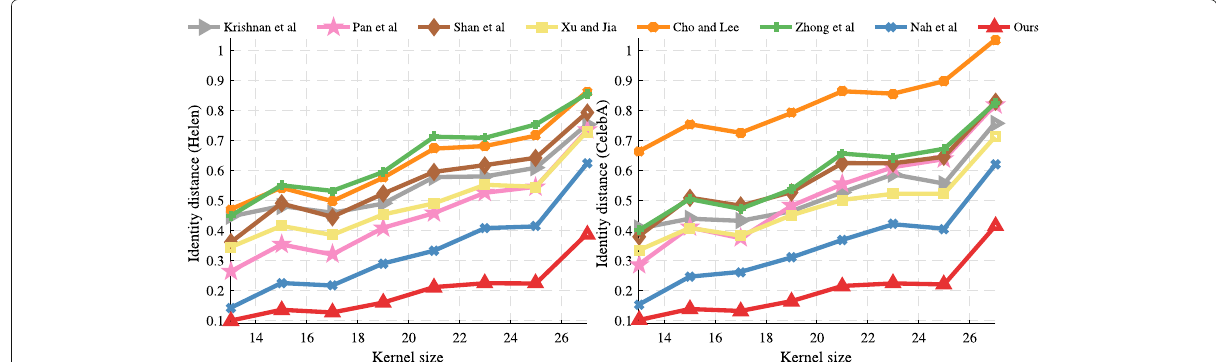
Fig. 9 Evaluation on face identity distance. There are 100 identities chosen from CelebA dataset and we randomly choose other 9 images for each identity. That is to say, the probe data and gallery data are composed of 8000 deblurred face images and 900 images respectively. The curve demonstrates that the proposed method performs favorably against state-of-the-art